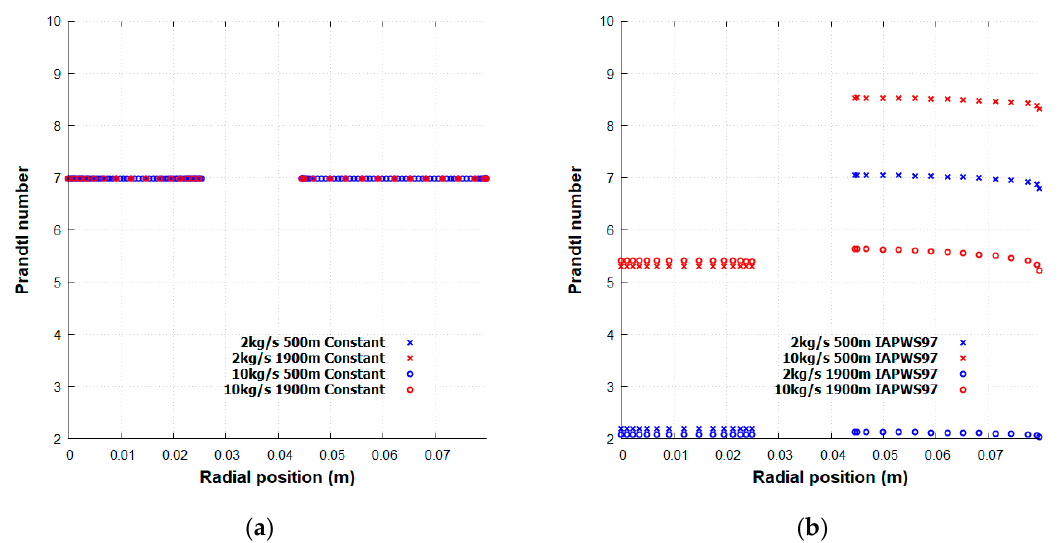
Figure 6. CFD study. ( a ) Radial Prandtl number at − 500 m and − 1900 m for constant water properties. ( b ). Radial Prandtl number at − 500 m and − 1900 m using the IAPWS IF97 properties.